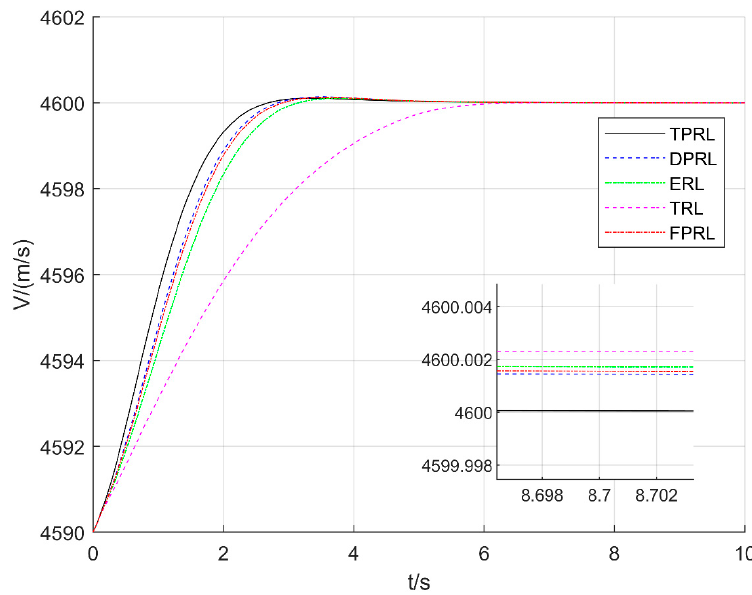
Figure 4. Velocity tracking under reaching laws.